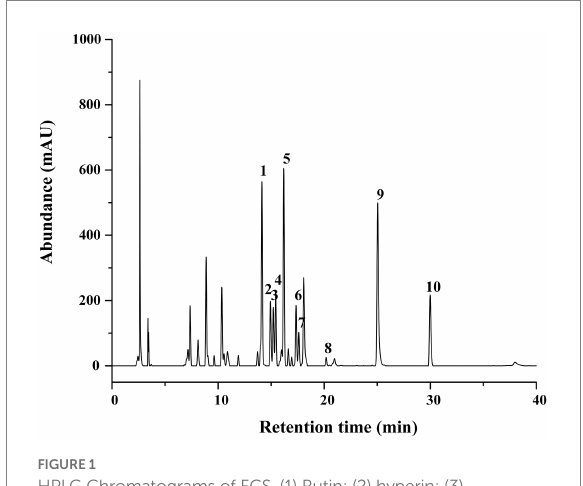
FIGURE 1 HPLC Chromatograms of FCS. (1) Rutin; (2) hyperin; (3) isoquercitrin; (4) luteoloside; (5) kaempferol-3- O -rutinoside; (6) luteolin-5- O -glucoside; (7) astragalin; (8) afzelin; (9) quercetin; (10) kaempferol.